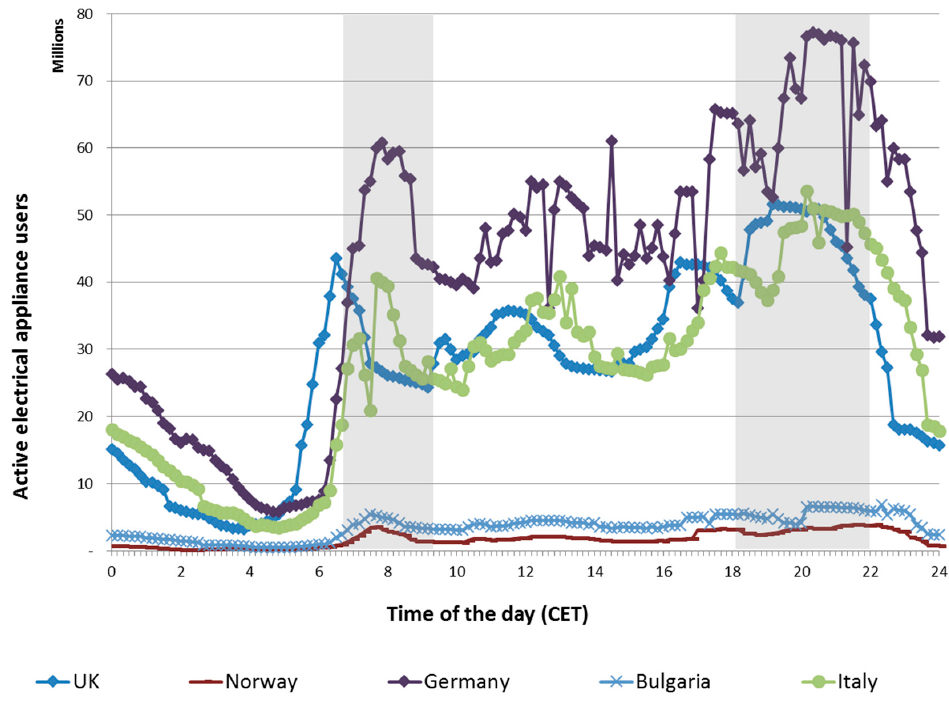
Figure 3. Active electrical appliance users.